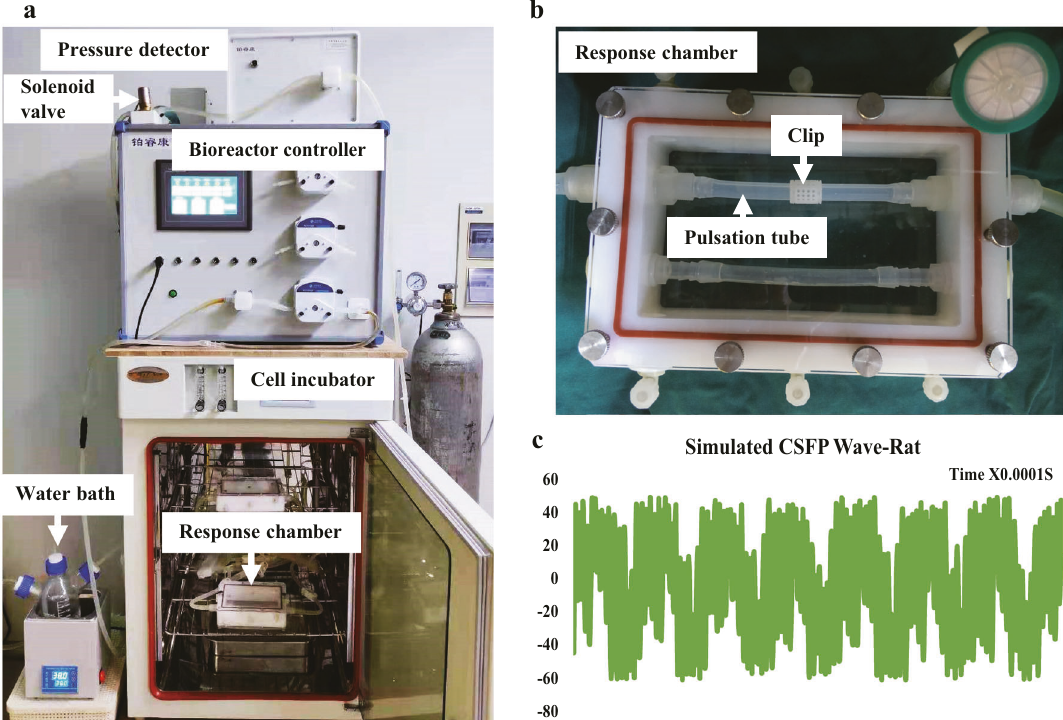
Fig. 1 Cerebrospinal fl uid pulsation bioreactor system. a The modules of the bioreactor system. b The response chamber of the bioreactor, the MSC-PLGA complexes were fi xed on the pulsation tube using the clip. c The mimicked rat cerebrospinal fl uid stress wave by the bioreactor